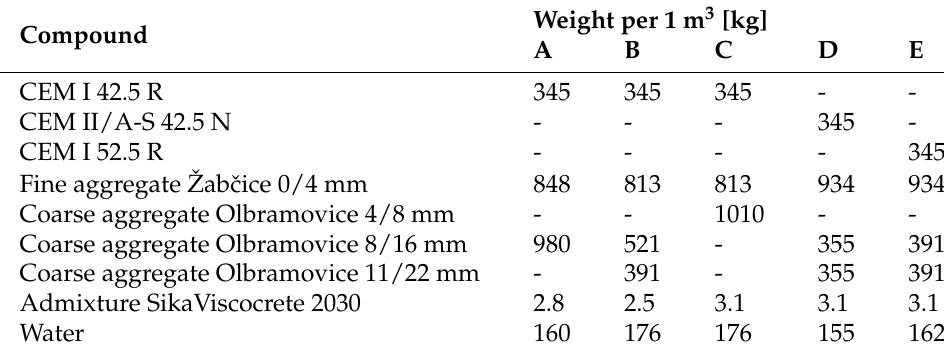
Table 2. Composition of designed